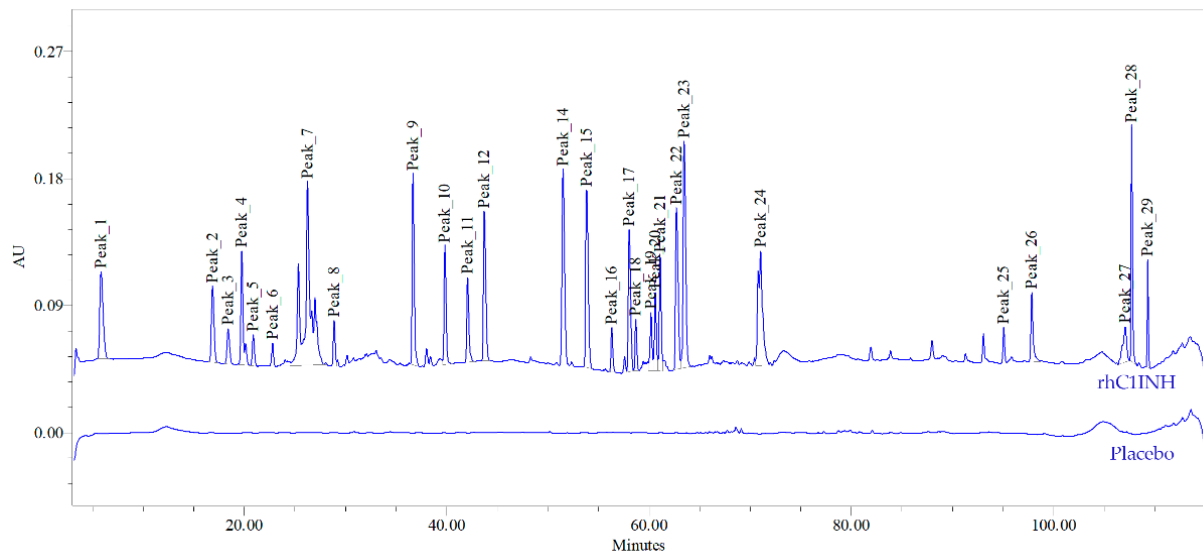
Figure 3. The rhC1INH peptide mapping chromatogram.